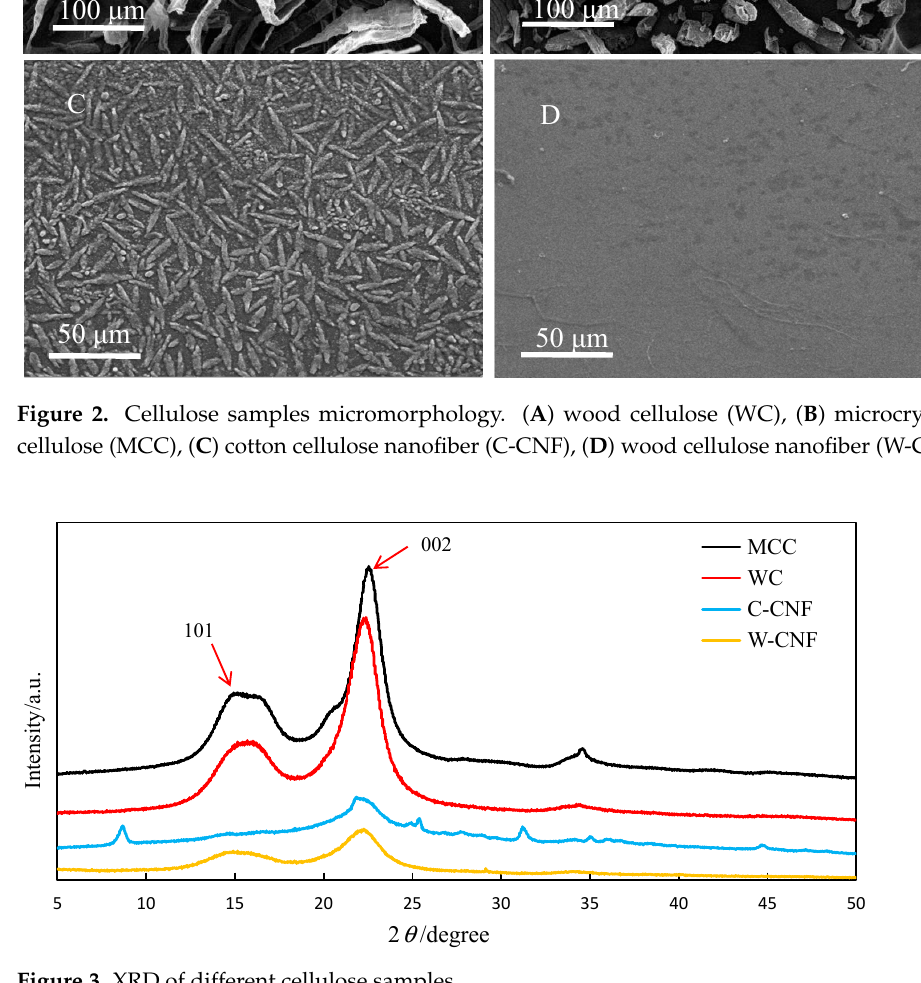
Figure 2. Cellulose samples micromorphology. ( A ) wood cellulose (WC), ( B ) microcrystalline cel- lulose (MCC), ( C ) cotton cellulose nanofiber (C-CNF), ( D ) wood cellulose nanofiber (W-CNF).